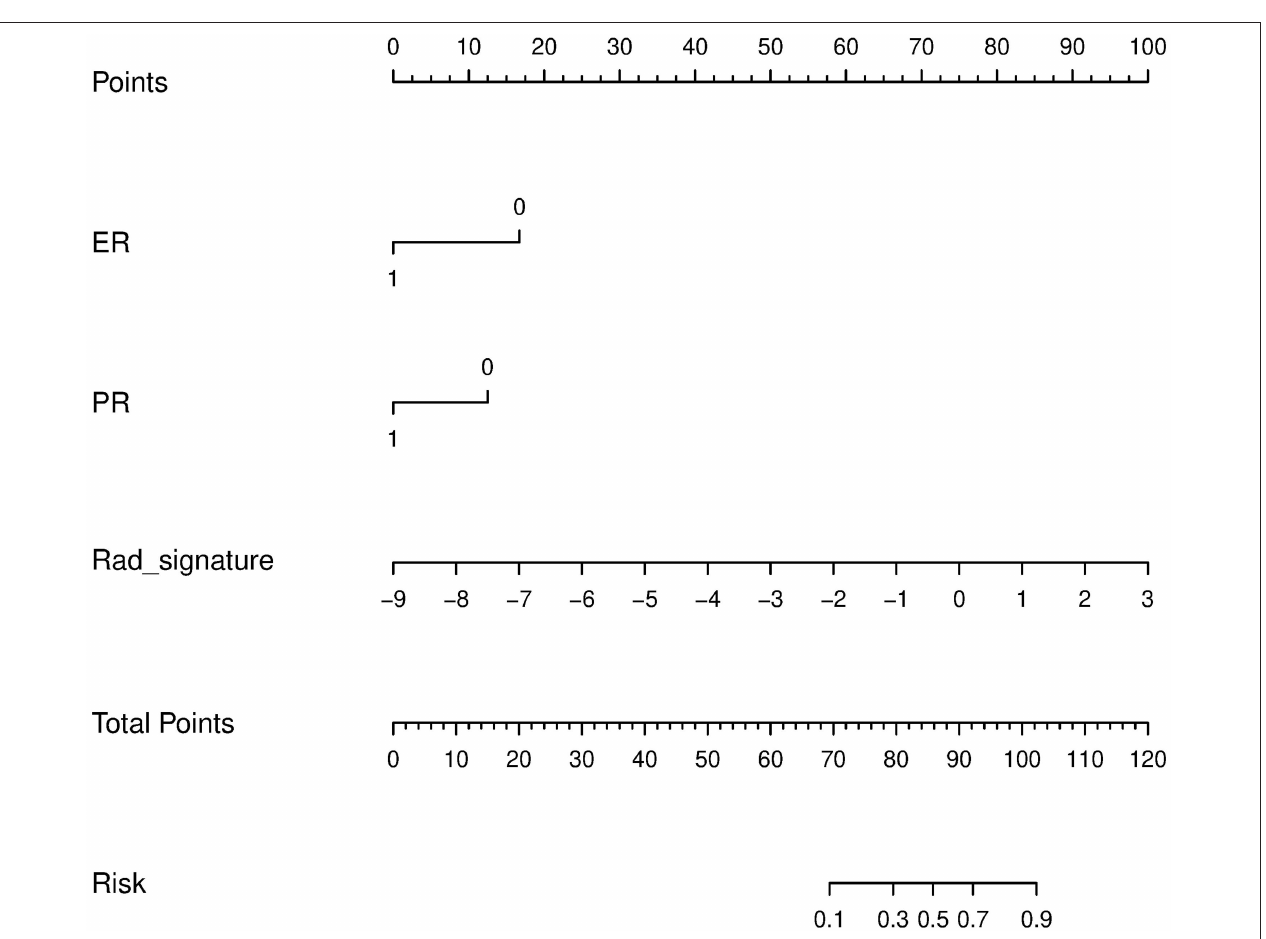
FIGURE 5 | Radiomics nomogram to predict the patient with pCR. The radiomics nomogram was developed in the training set, with the rad-score, ER status, and PR status. scores were estimated using the nomogram, and patients were classified into the high and low probability groups according to the Yonden index (cut-off: 0.3371), which was based on